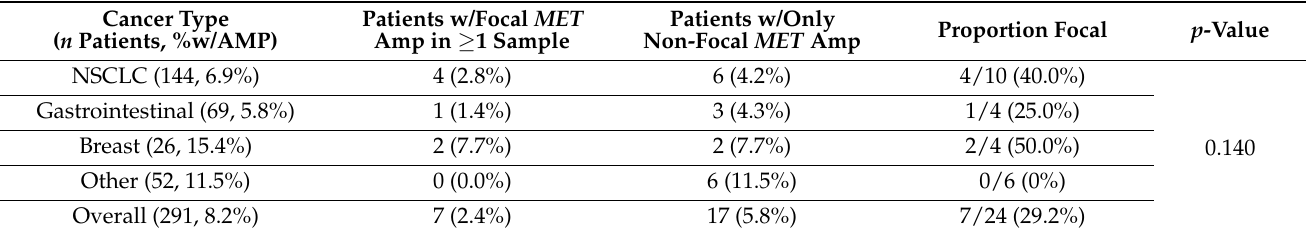
Figure 4. Copy number differences of four genes between MET focal and non-focal groups. This figure shows a comparison of the copy number sizes of the four genes in MET focal vs. non-focal. The copy number of the focal MET amp was significantly higher than that of non-focal ( p = 0.0304). On the other hand, the copy number of CDK6 and BRAF of the focal MET amp was significantly lower than that of the non-focal ( p = 0.0278 and p = 0.0086, respectively), indicating that CDK6 and BRAF are co-amplified with MET in non-focal. The copy number of EGFR was not significantly different between MET focal and non-focal ( p = 0.421). Table 3. Focal vs. non-focal MET amplification by cancer type in training set ( n =